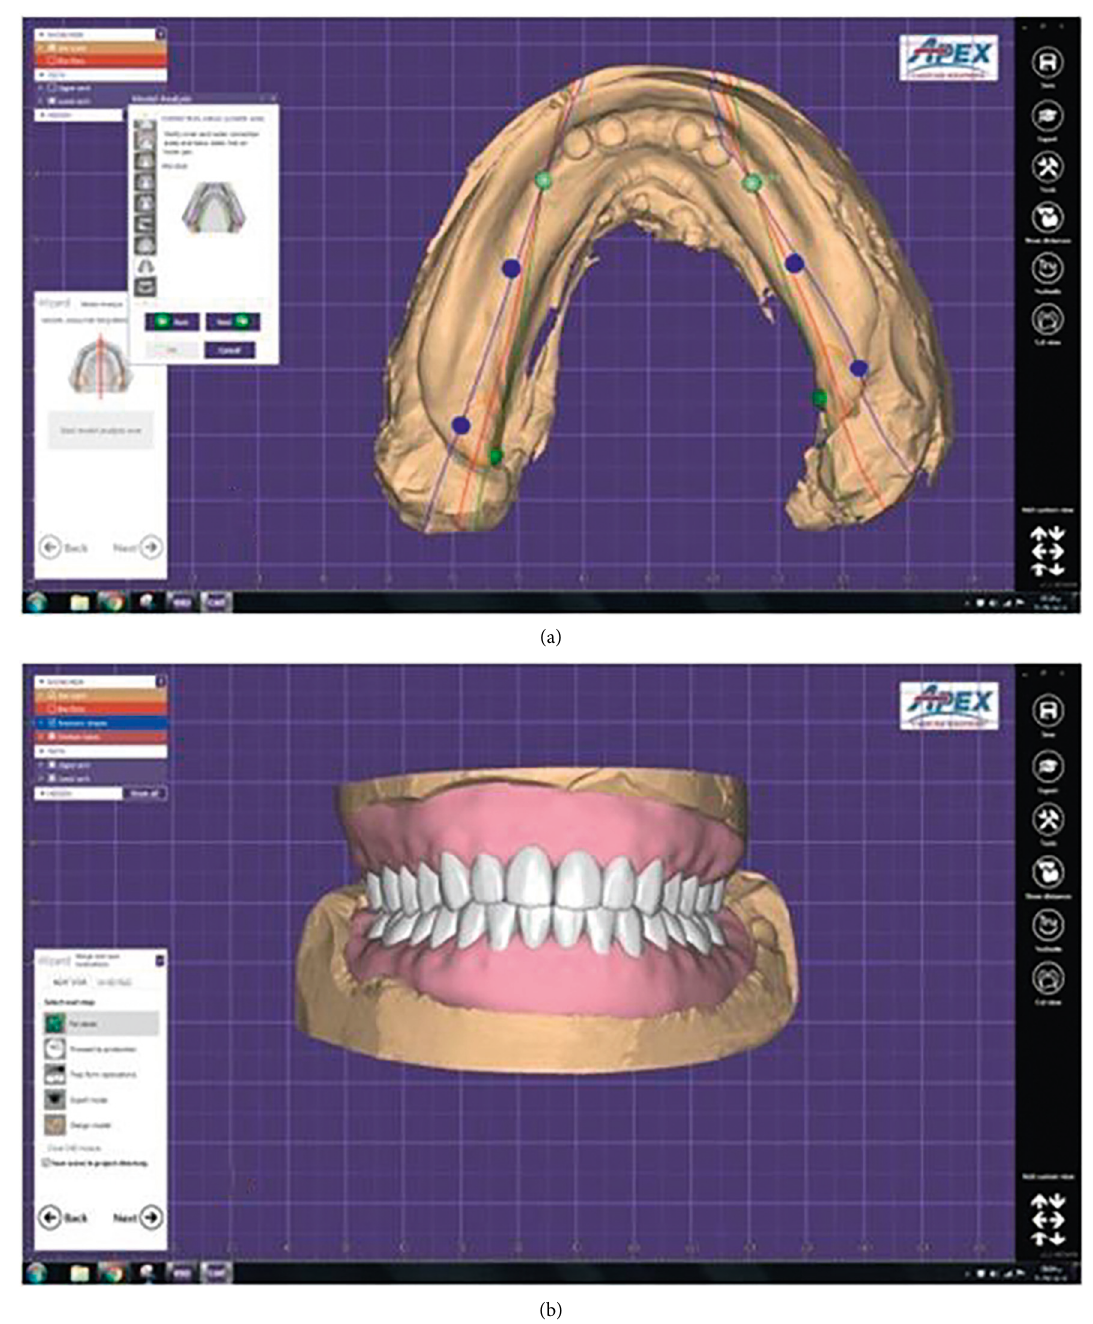
Figure 3: The virtual master cast (a) and virtual trial denture